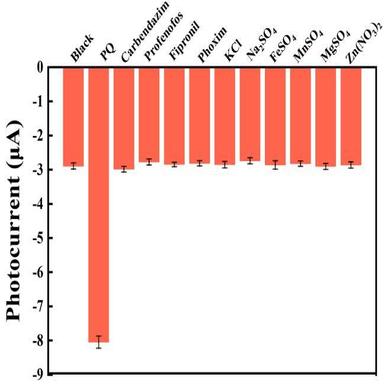
The sensing specificity of ITO/Au/Cu2O for PQ in solution (10-6 mol L-1) in the presence of the several interferences (10-4 mol L-1).